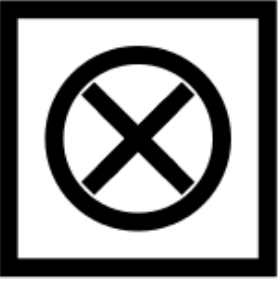
Figure 1. Landing zone pattern utilized at the MBZIRC competition